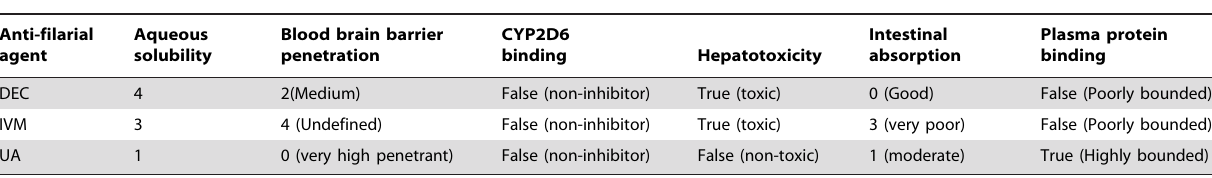
Table 3. Predicted ADME parameters (DS v3.5, Accelrys,